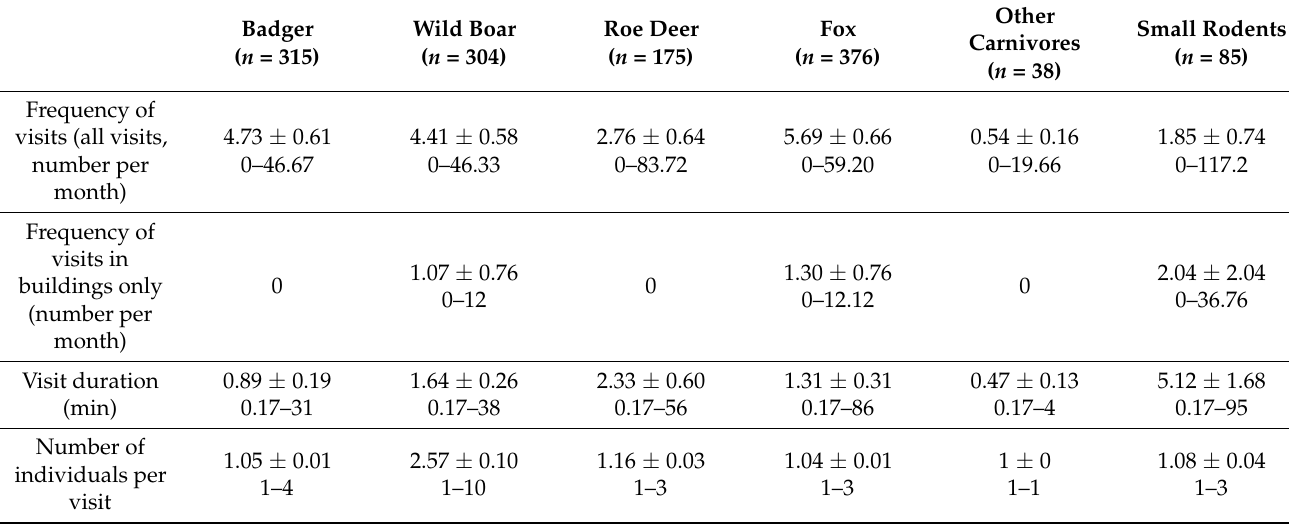
Table 3. Description of wild mammal visits. Mean ± SE and range are shown for frequency of visits per month, visit duration, and number of individuals per